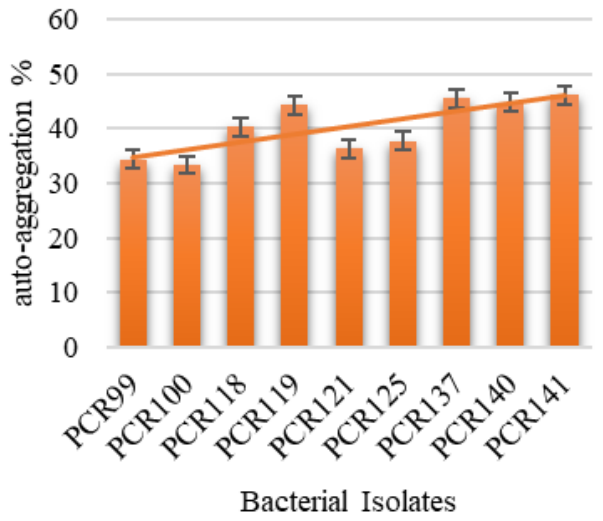
Figure 3. Determination of Auto-aggregation % of isolated bacterial strains.